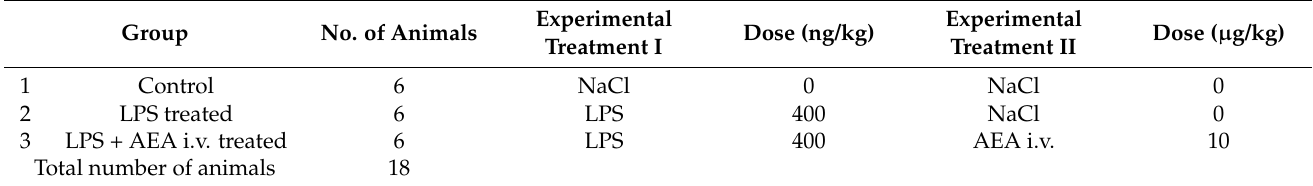
Table 1. Experiment organization